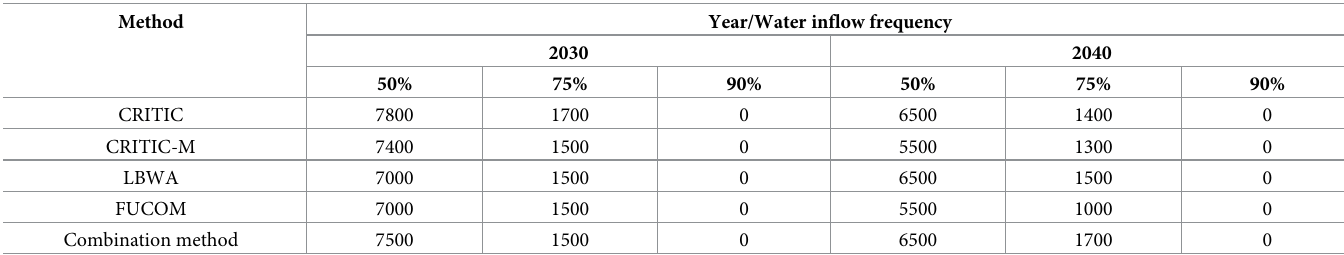
Table 9. Theoretical values of water right trading volume under four weights (10 4 m 3 ).